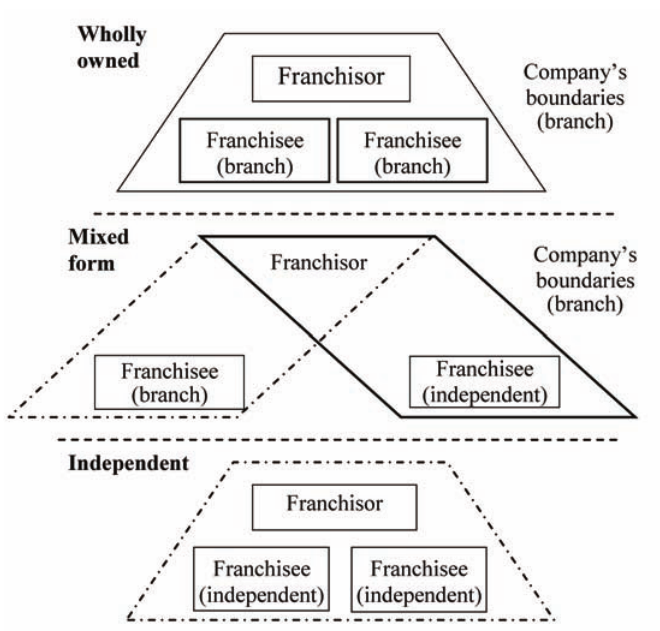
Fig. 2. Governance structure alternatives in franchising (made by author in accordance to Hendrikse and Jiang